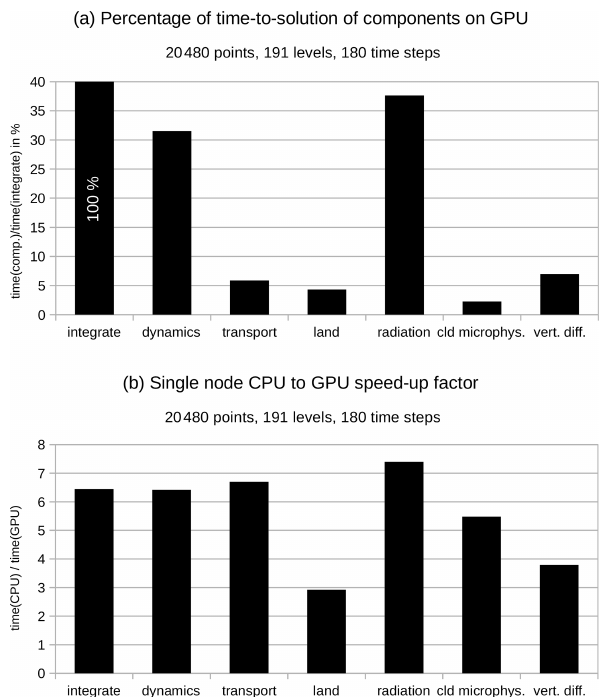
Figure 4. For a small setup with 20480 grid points and 191 lev- els integrated over 180 time steps: (a) time to solution on GPU of the model components as percentage of the time for the “integrate” timer that measures the whole time loop and (b) the CPU-to-GPU speedup for the whole time loop as well as the model